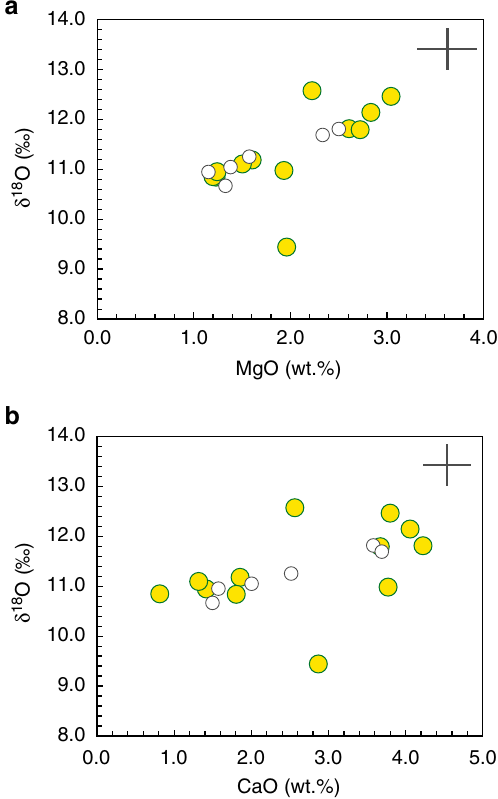
Fig. 3 New and published δ 18 O values vs. MgO a and CaO b in moldavites. The wider range in δ 18 O values from this study ( yellow circles ) is not re fl ected in distinctive major element compositions 4 , compared with other published data 51, 83 . The 2 s.d. error bars are